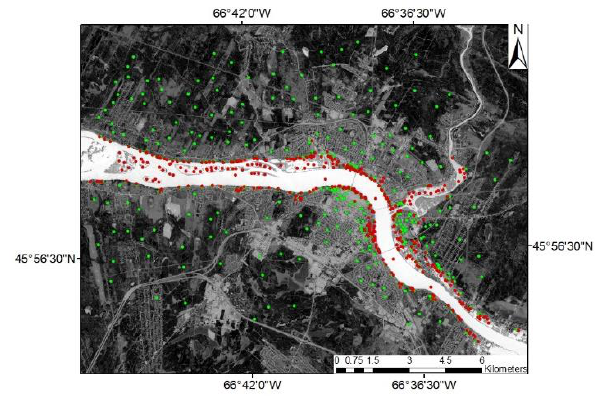
Figure 2. NDWI and sample points generated from Sentinel-2 satellite image at the flood